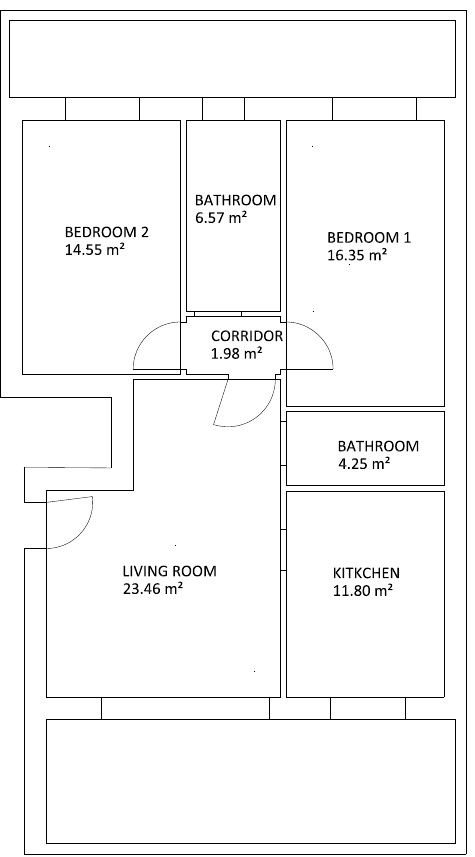
Figure 1. Sound pressure level measurements. Apartment plan.